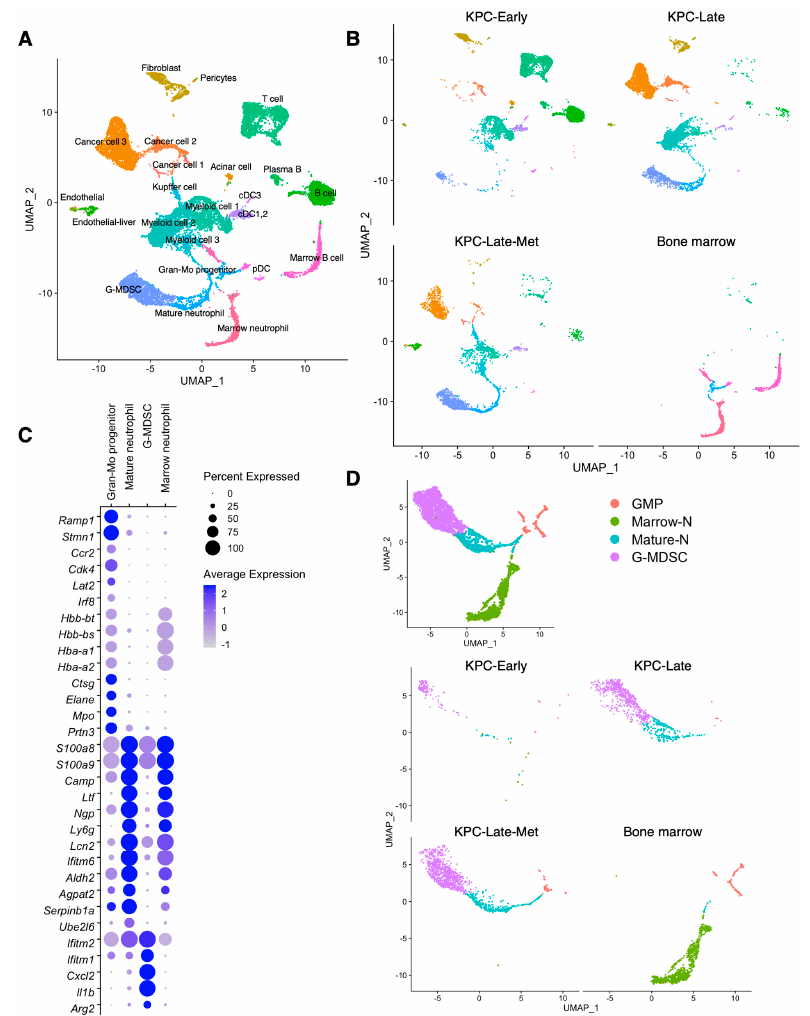
Figure 8. The similarity and difference of granulocyte/neutrophil subclusters across primary tumors, liver metastases, and normal bone marrow. ( A , B ) Cross-comparison of scRNA-seq datasets of KPC-Early, KPC-Late, and KPC-Late-Met groups compared with normal bone marrow of background-matched healthy mice ( n = 2; total cell number 2241), as published by previous datasets (GSE184360). The major cell clusters were defined using the same threshold used in Figure 1, as shown in UMAP plot ( A ). The cell population compositions are compared across KPC-Early, KPC-Late, KPC-Late-Met, and bone marrow groups ( B ). ( C , D ) Expression profile of indicated marker genes among defined granulocyte/neutrophil subpopulations is shown in dot plot with the normalized expression levels of indicated signature genes ( C ). Granulocyte/neutrophil subpopulations from primary tumors, liver metastases, and normal bone marrow are characterized in UMAP plot and compared across KPC-Early, KPC-Late, KPC-Late-Met, and bone marrow groups ( D ). G-MDSC, granulocytic myeloid-derived suppressor cell; Gran-Mo progenitor, granulocyte-monocyte progenitor